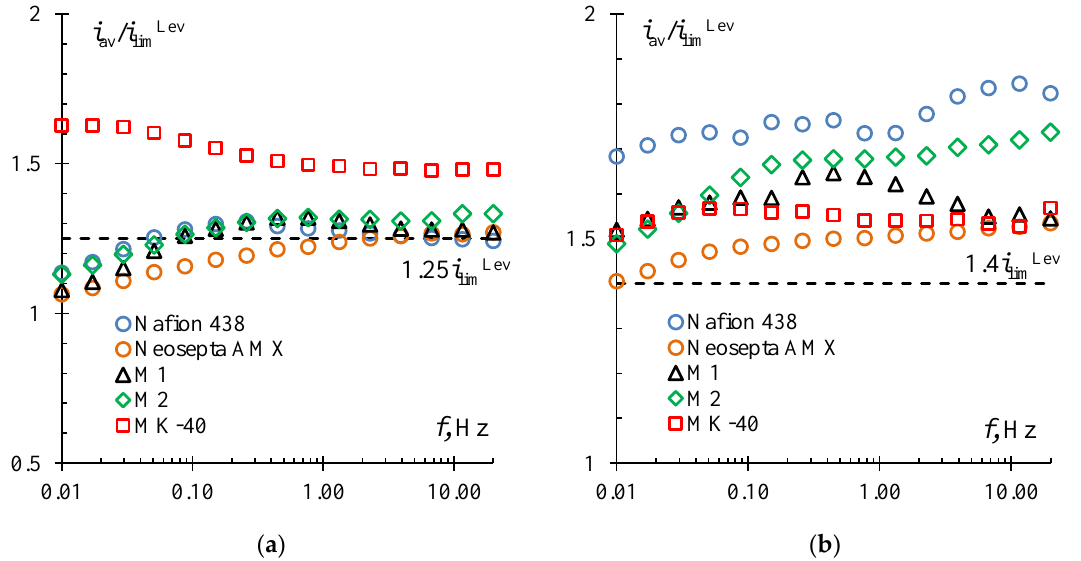
Figure 7. The results of testing the Nafion 438, Neosepta AMX, M1, M2, and MK-40 membranes in the pulsed electric field mode: i = 1.25 i limLev , duty cycle 1/2 (excluding results for M1, M2 membranes for which they are shown at 1.25 i limLev and α = 1/3) ( a ), and 1.4 i limLev , duty cycle 1/2 (excluding results for Neosepta AMX membrane for which they are shown at 1.4 i limLev and α = 3/4) ( b ). The horizontal dashed line denotes the i / i limLev ratio corresponding to a given potential drop U av in the DC mode.